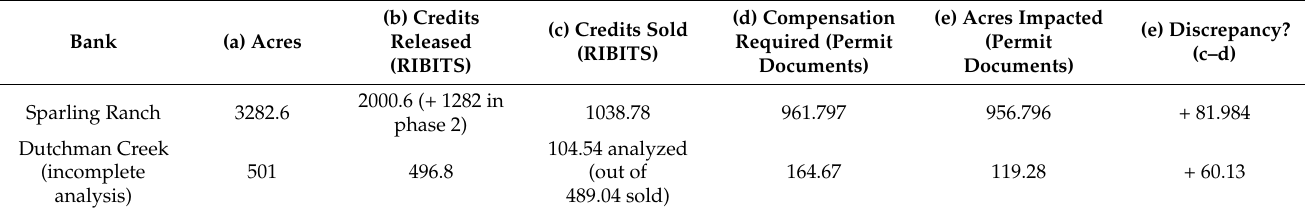
Table 1. Gains and Losses in